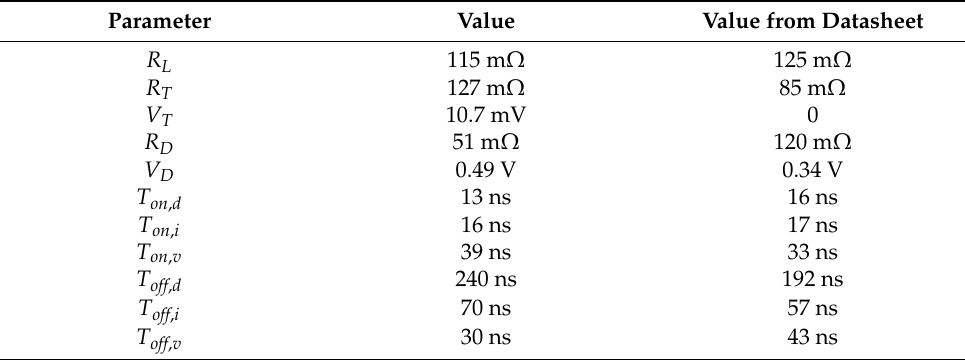
Table 1. Measured parameters of converter components.